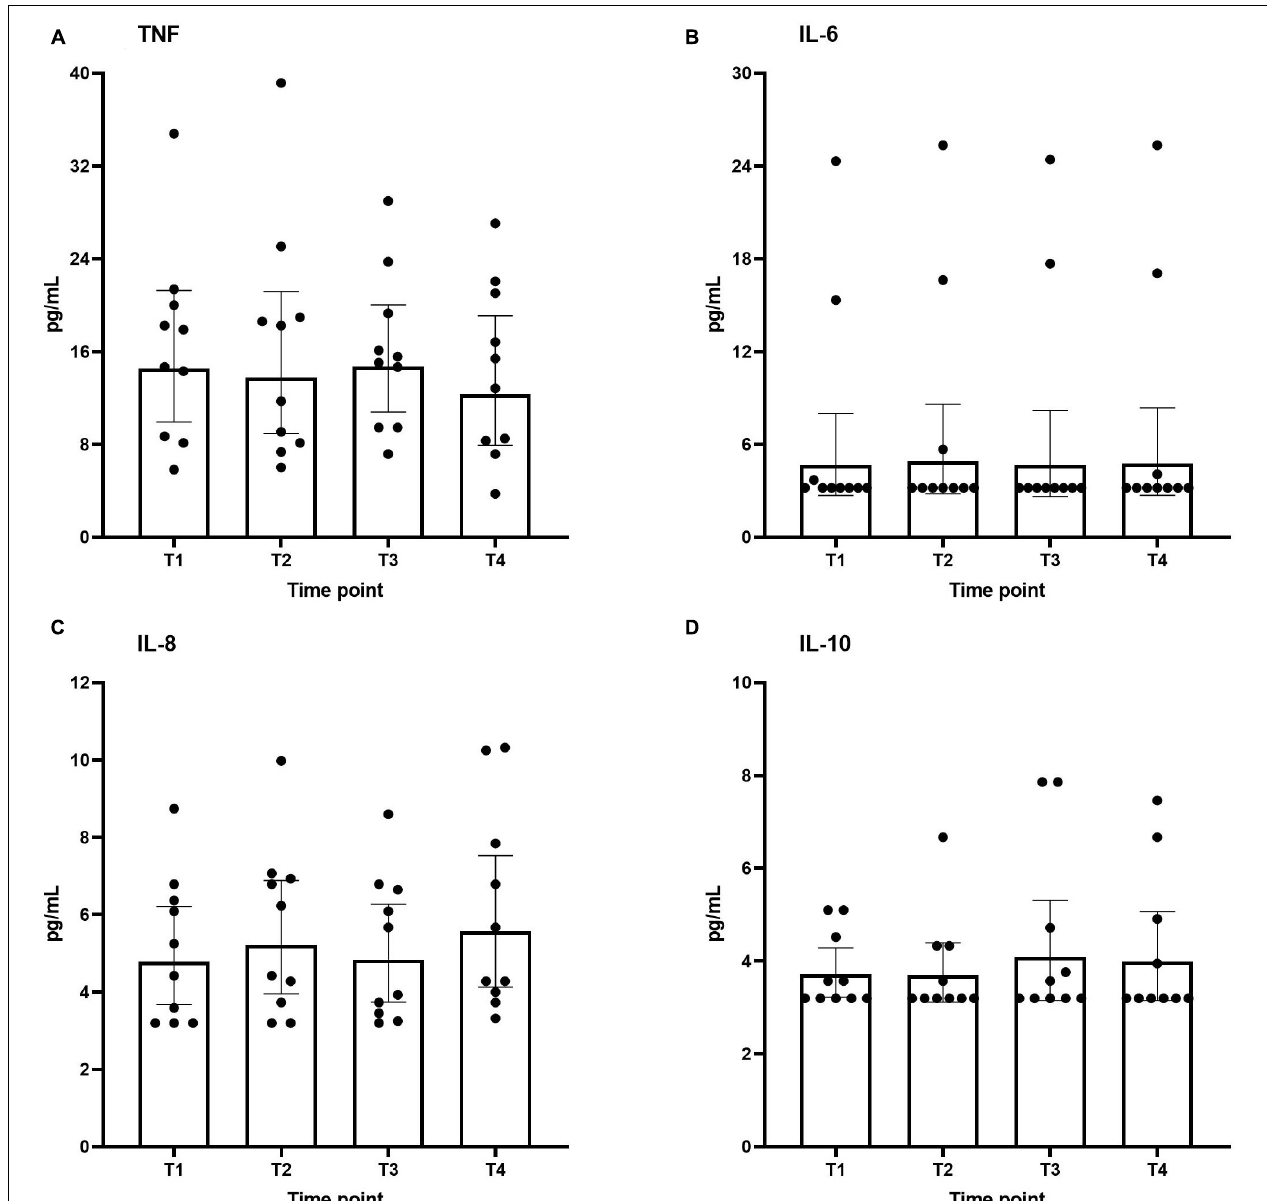
FIGURE 3 | Plasma levels of interleukin IL-6 (A) , IL-8 (B) , IL-10 (C) , and TNF (D) during the study period. Data are represented as scatter plots with bars indicating geometric mean and whiskers representing 95% confidence interval